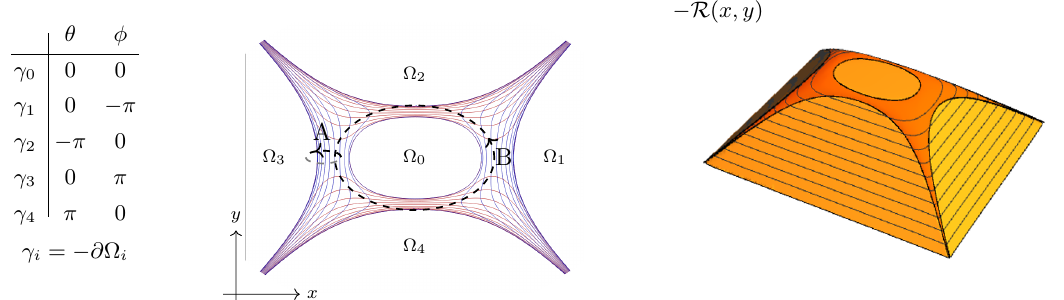
Figure 3 . Left: amoeba are for φ = const , their values are taken for one of two sheets of ovals Ω i are oriented counter-clockwise along ∂ by dashed lines. Right: minus Ronkin function